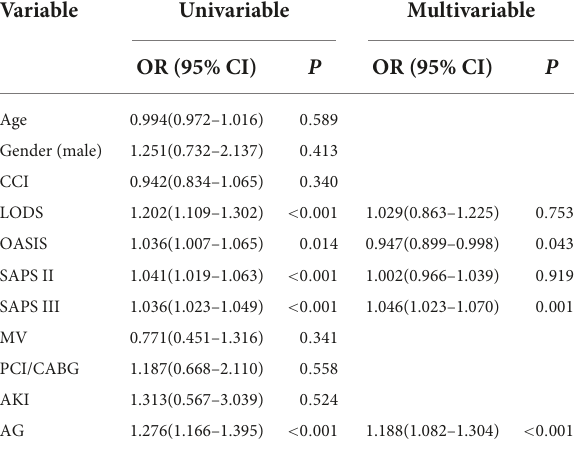
TABLE 3 Binomial logistic regression analysis for in-hospital mortality among coronary care unit patients with AMI (after PSM).